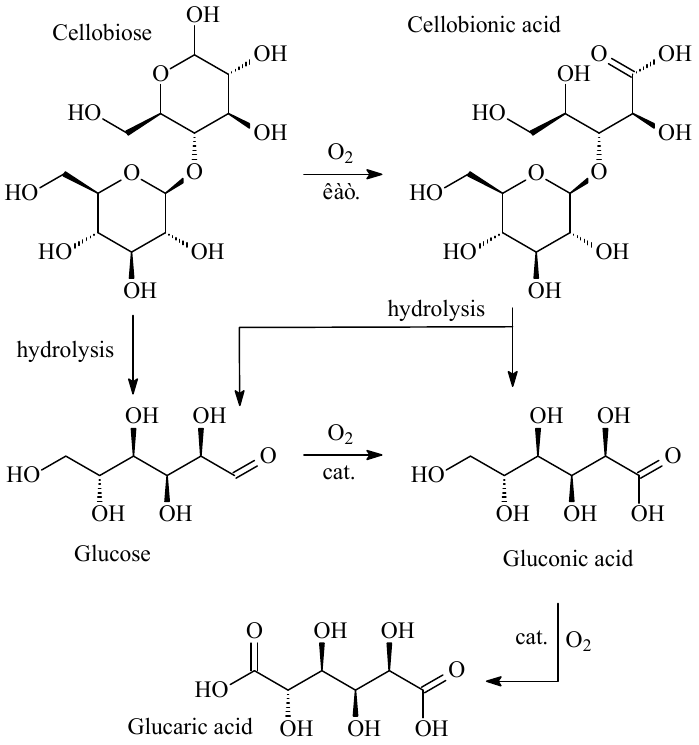
Figure 7. Proposed scheme for the conversion of cellobiose into gluconic and glucaric acids in the presence of a catalyst, 3% Pt/HPS MN270.